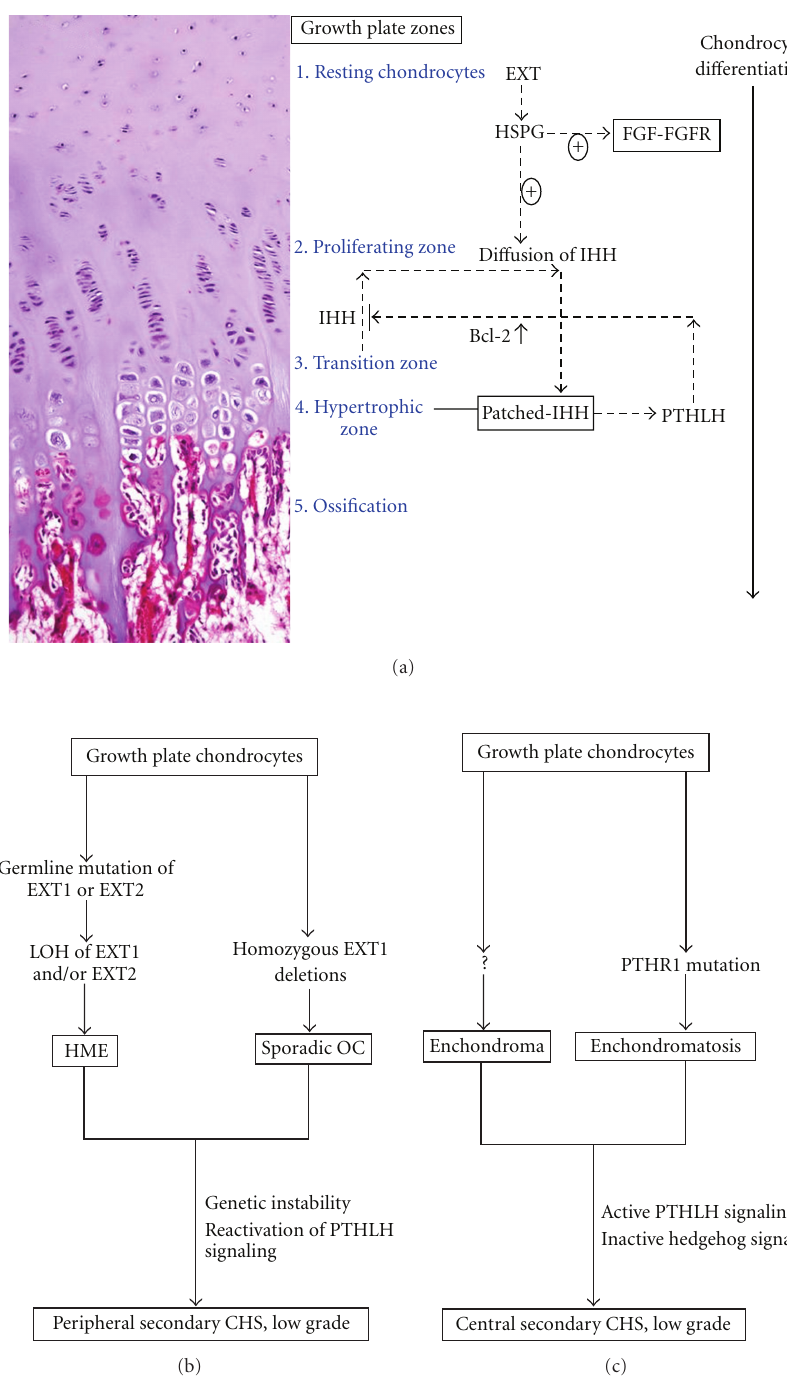
Figure 8: (a) Schematic representations of IHH/PTHLH signaling in the growth plate. The growth plate is composed of chondrocytes at di ff erent stages of di ff erentiation, finally leading to longitudinal bone growth. This process is tightly regulated by IHH/PTHLH signaling. IHH, expressed by transition zone chondrocytes, di ff uses and binds to Patched (Ptc) in the hypertrophic zone, stimulating PTHLH expression. PTHLH then binds to its receptor in the transition zone and upregulates Bcl-2, which inhibits chondrocyte di ff erentiation and downregulates IHH secretion. EXT gene products play a role in the di ff usion of hedgehog proteins and FGF-FGFR interaction. Therefore, defect or absence of EXT genes results in an abnormal IHH di ff usion pattern, leading to an osteochondroma. (b) Proposed genetic model for peripheral secondary CHS. Analogous to Knudson’s two-hit model, both alleles of an EXT gene are inactivated for osteochondroma formation in both HME and solitary osteochondroma. Genetic instability and reactivation of PTHLH signaling characterizes the malignant transformation of osteochondroma. (c) Proposed genetic model for central secondary CHS. Patients with enchondromatosis infrequently harbor PTHR1 mutation, which disrupts the normal IHH-PTHLH feedback loop, leading to constitutive hedgehog signaling. In most enchondromas, causative genetic or epigenetic changes have not been